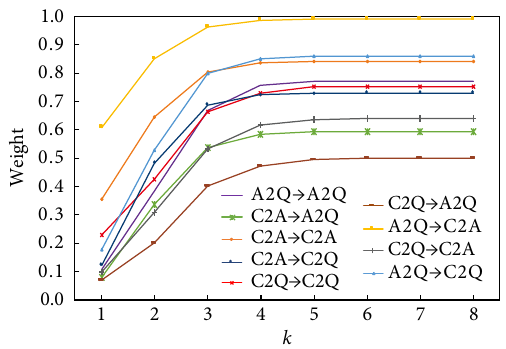
Fig. 9 Experimental result on the Ask-Ubuntu